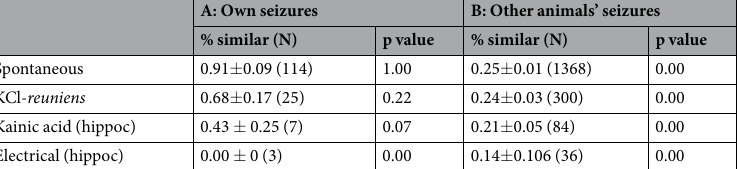
Table 2. Comparison of seizure features Tabulated results for quantitative seizure comparison. After determining the distribution of each animal’s spontaneous seizures (see Fig. 4), every seizure from every animal was compared to that distribution. Column A: seizures occurring during the KCl- reuniens injection method were not significantly different from the spontaneous seizures, while those induced by both kainic acid and electrical stimulation were different ( χ 2 ). Column B: when comparing seizures across different animals, other animals’ seizures were very different each animal’s own spontaneous seizures. These results prove that seizures are different across different animals and that the seizures occurring during the KCl- reuniens method are similar to a given animal’s own